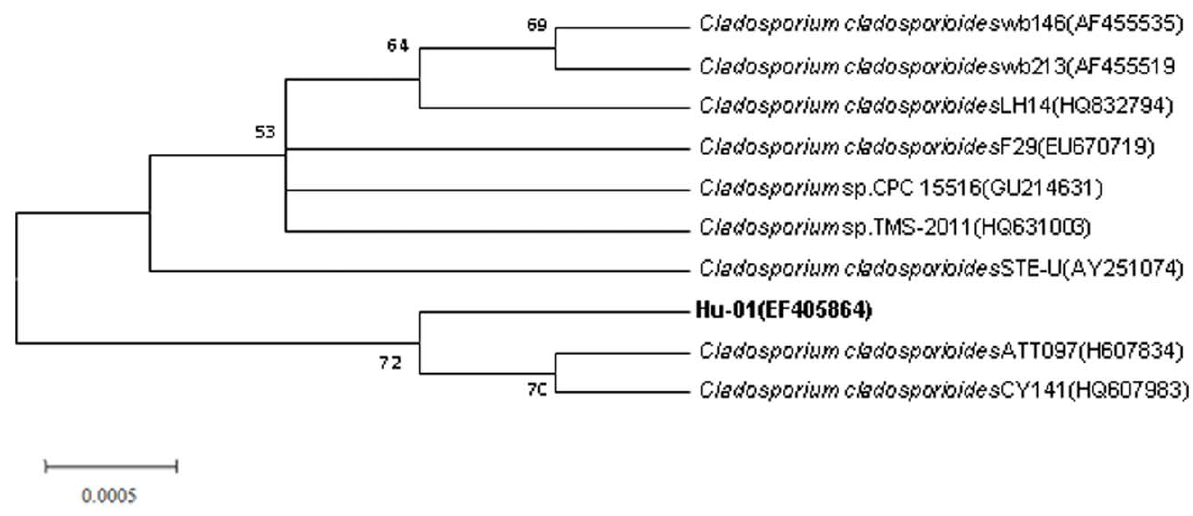
Figure 2. Phylogenetic tree based on the 5.8S rRNA sequence of strain Hu-01 and related strains. Numbers in parentheses represent the sequences accession number in GenBank. Numbers at the nodes indicate bootstrap values from the neighborhood-joining analysis of 1,000 resampled data sets. Bar represents sequence divergence.